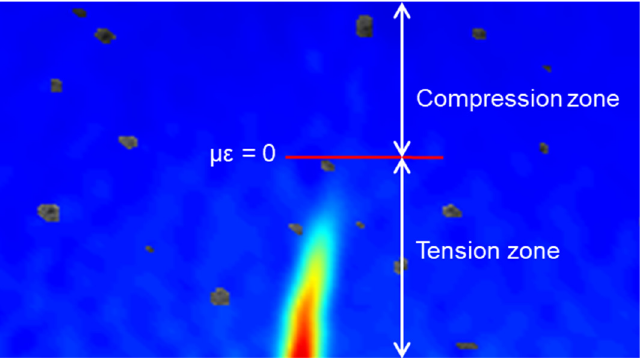
Figure 10. Schematic diagram of the compression and tension zones.